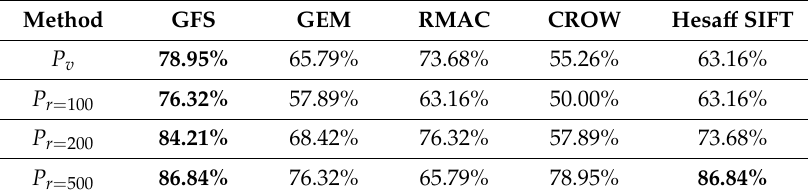
Table 7. Results of the method